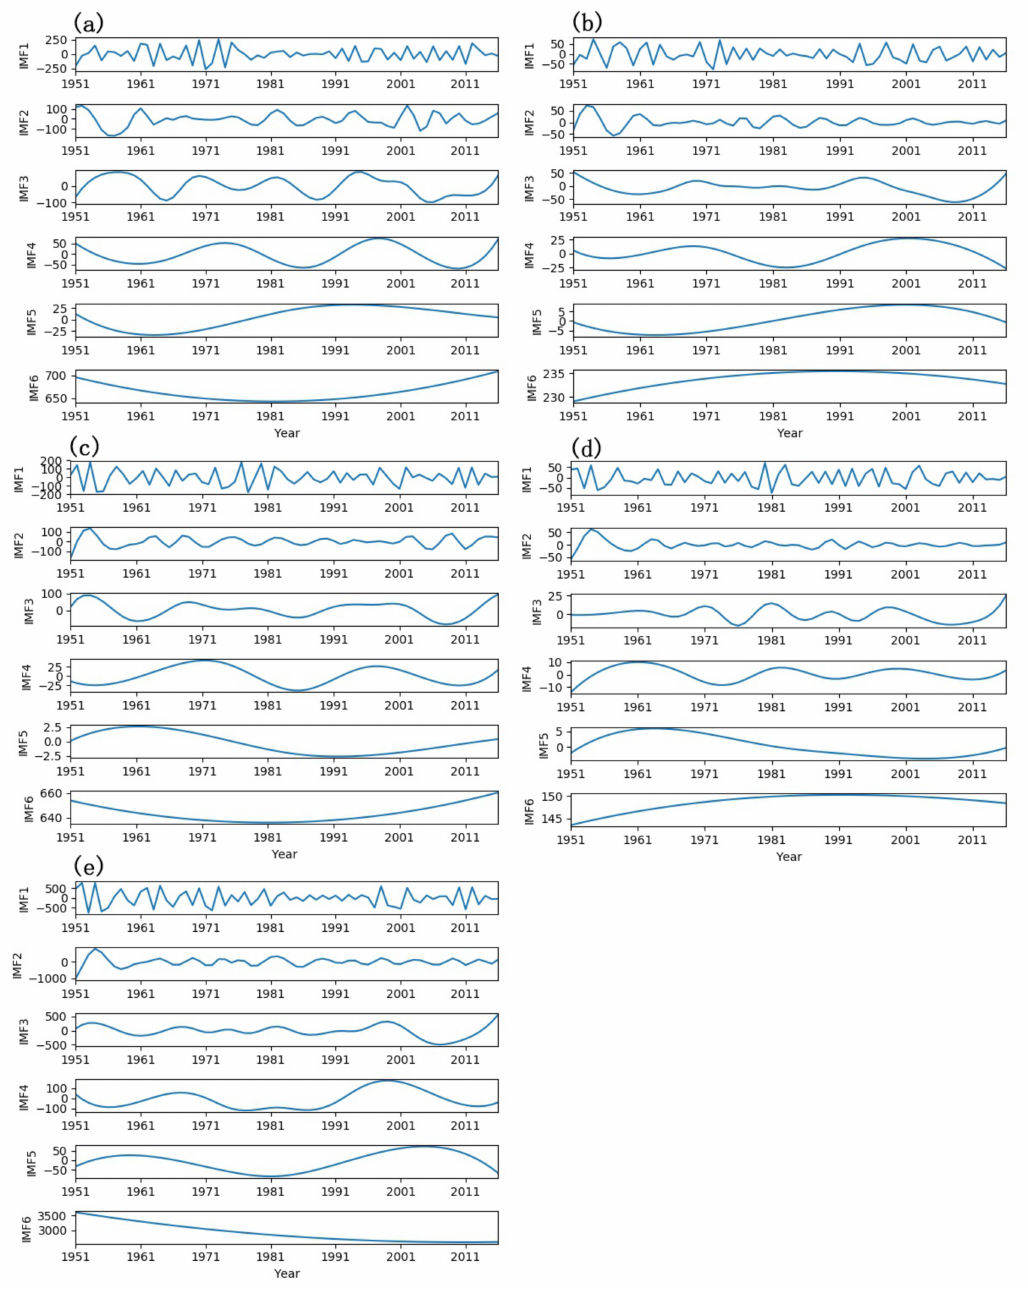
Figure 3. Decomposition of annual runoff time series of ( a ) Xiangtan station; ( b ) Taojiang station; ( c ) Taoyuan station; ( d ) Shimen station and ( e ) Chenglingji